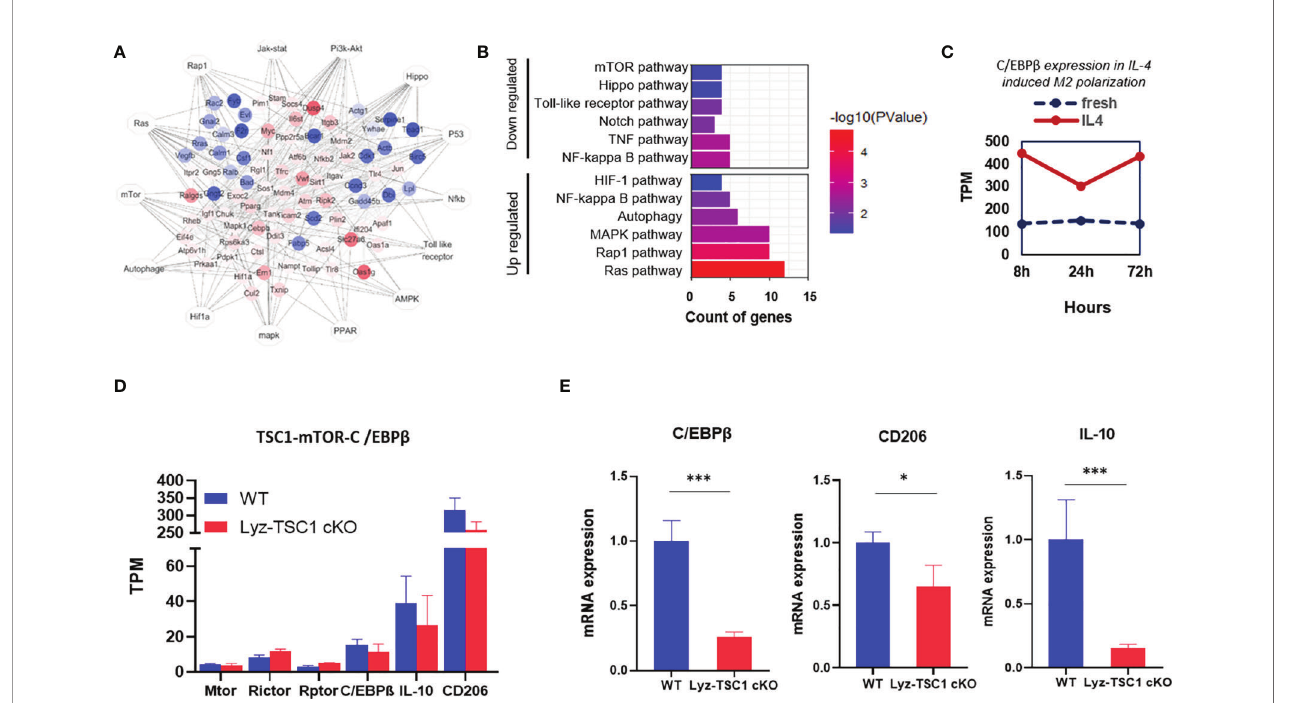
FIGURE 6 | Decreased C/EBP b expression in TSC1 cKO renal macrophages during the repair phase of IRI may also be induced by overactivated mTOR activity. (A) Network summary of previous enrichment of the KEGG pathway related to M2 polarization. (B) Top 12 most up- and downregulated pathways by differential mRNA. (C) C/EBP b expression with or without IL-4 induced M2 polarization in the downloaded data. (D) TPM value of mTOR, Rictor, Raptor, C/EBP b , and IL-10 in macrophages from WT or Lyz-TSC1 cKO mouse kidneys 2 weeks after ischemia-reperfusion. (E) Relative expression of C/EBP b , CD206, and IL-10 in kidney macrophages sorted from WT and Lyz-TSC1 cKO mice on day 14 post-IRI. In (E) , the data are shown as the mean ± SD and were analyzed by an unpaired two- tailed Student ’ s t-test (n ≥ 3). *P < 0.05; **P < 0.01; NS, not signi fi